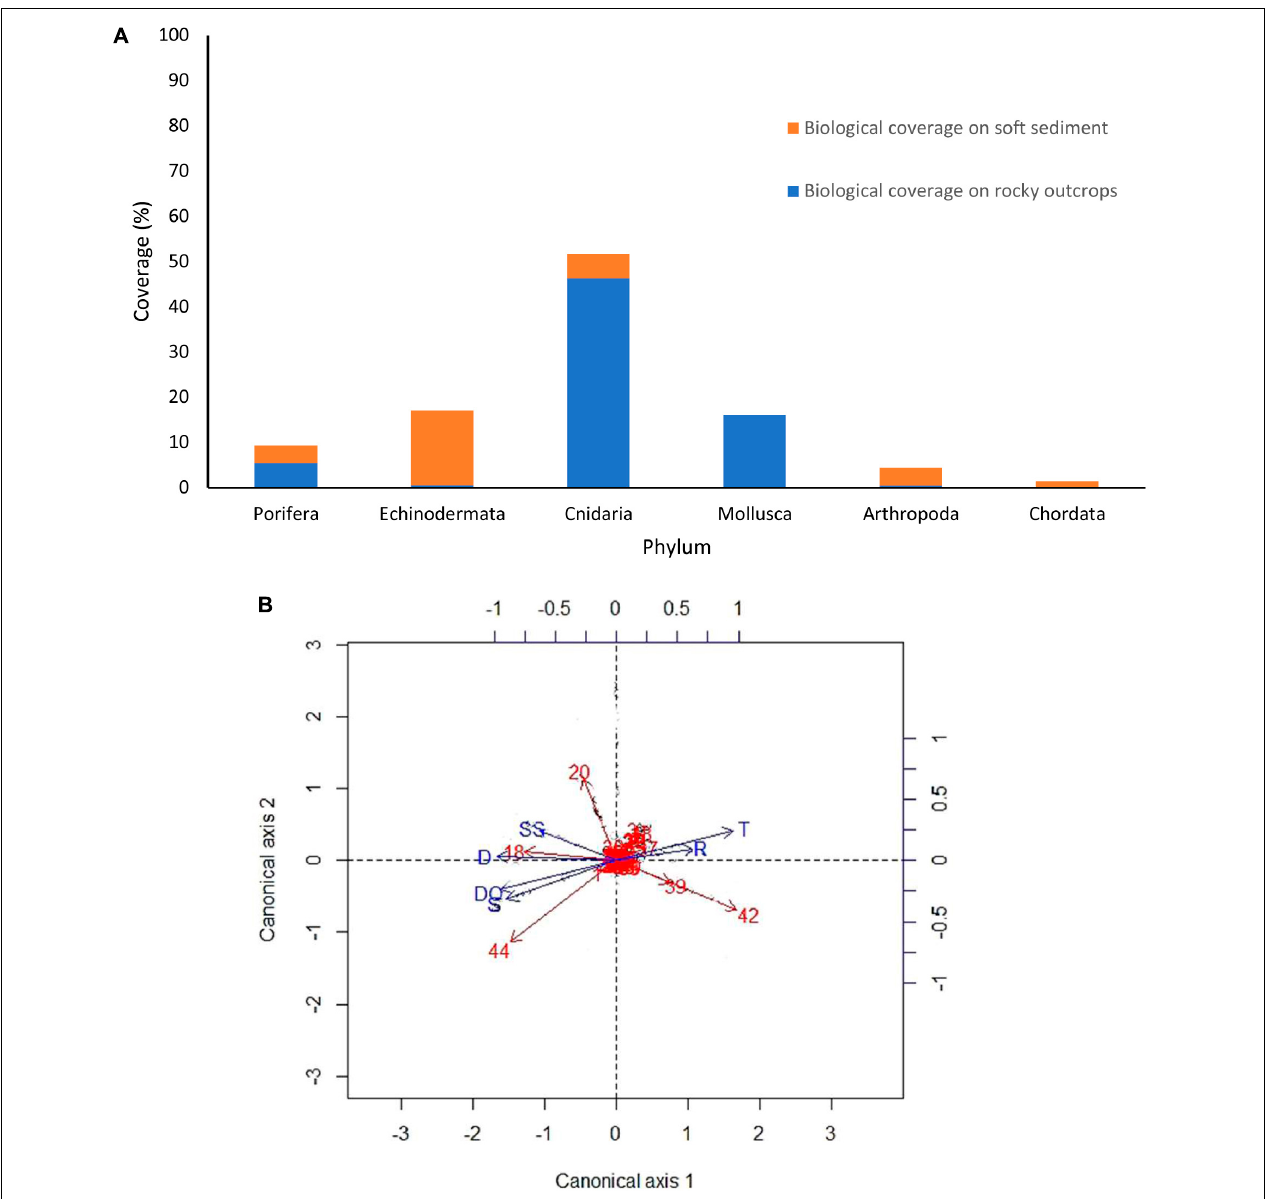
FIGURE 6 | (A) Biological coverage of epibenthic megafauna by phylum on soft sediment and rocky outcrops at dive D347 in the NW limit of Guaymas Basin and Sonoran Margin. (B) RDA triplot of the Hellinger-transformed cover data constrained by all environmental variables. Numbers = morphospecies code; SS = soft sediment; R = rocky outcrops; T = temperature; D = depth; S = salinity; DO = dissolved